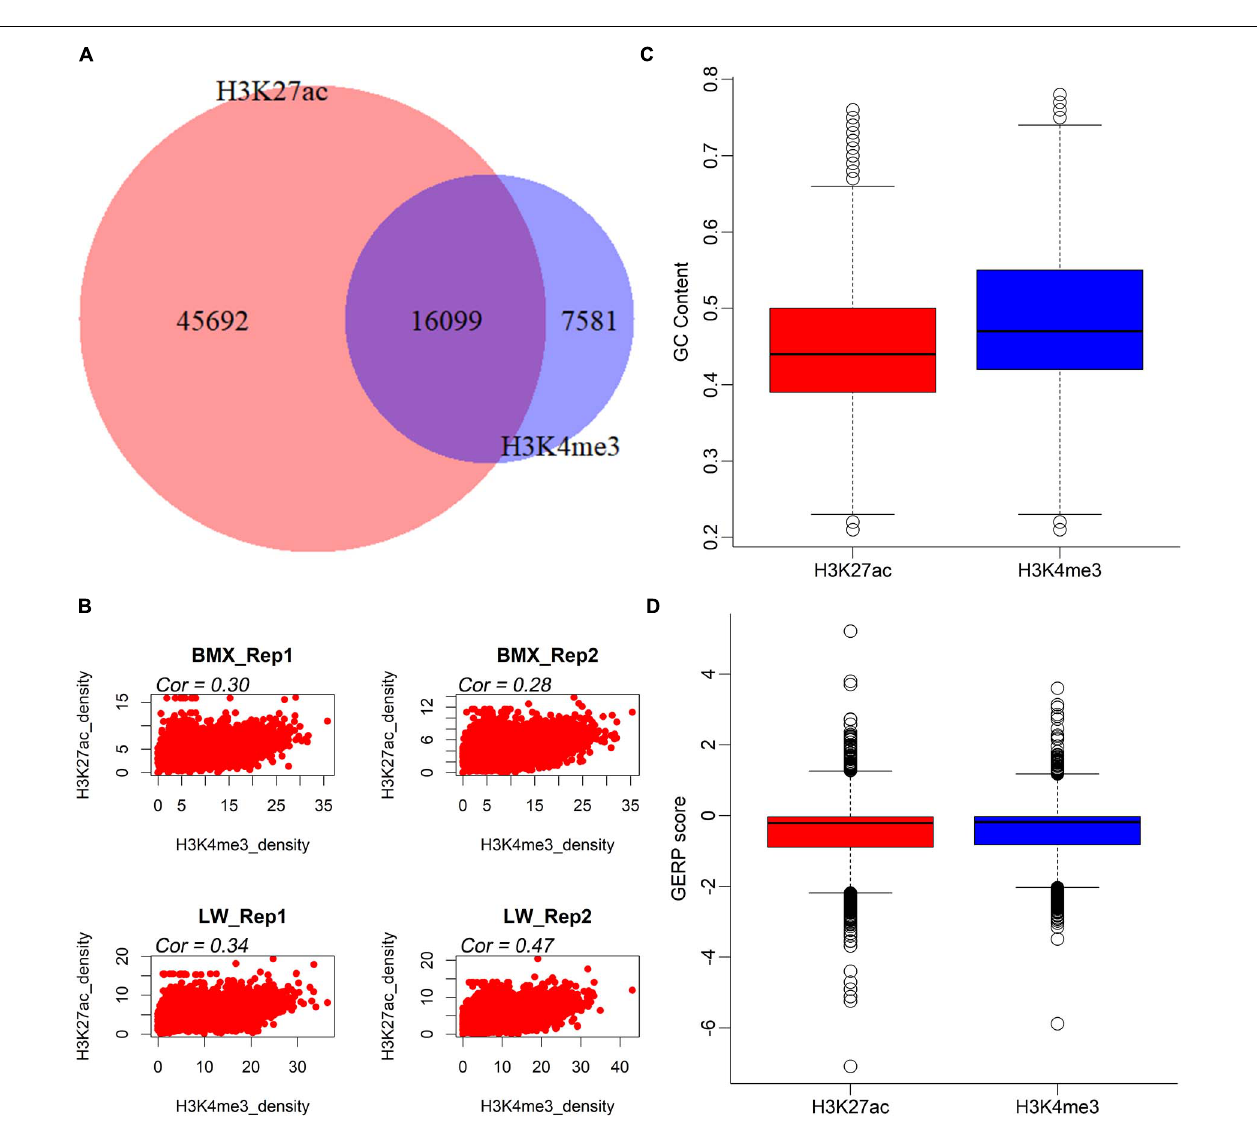
FIGURE 1 | The intersection and conservation of H3K27ac and H3K4me3 peaks. (A) The intersection of H3K27ac and H3K4me3 peaks. (B) The correlation of 16,099 overlapped peaks between two histone modifications in four individuals. (C,D) Boxplots comparing the GC contents and GERP scores of H3K27ac and H3K4me3